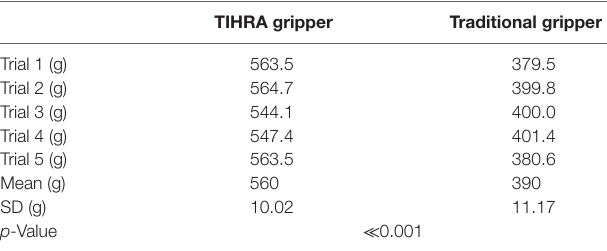
TaBle 1 | Values for the strength trials conducted for the Tihra gripper and the traditional, Fin ray ® effect gripper. Tihra